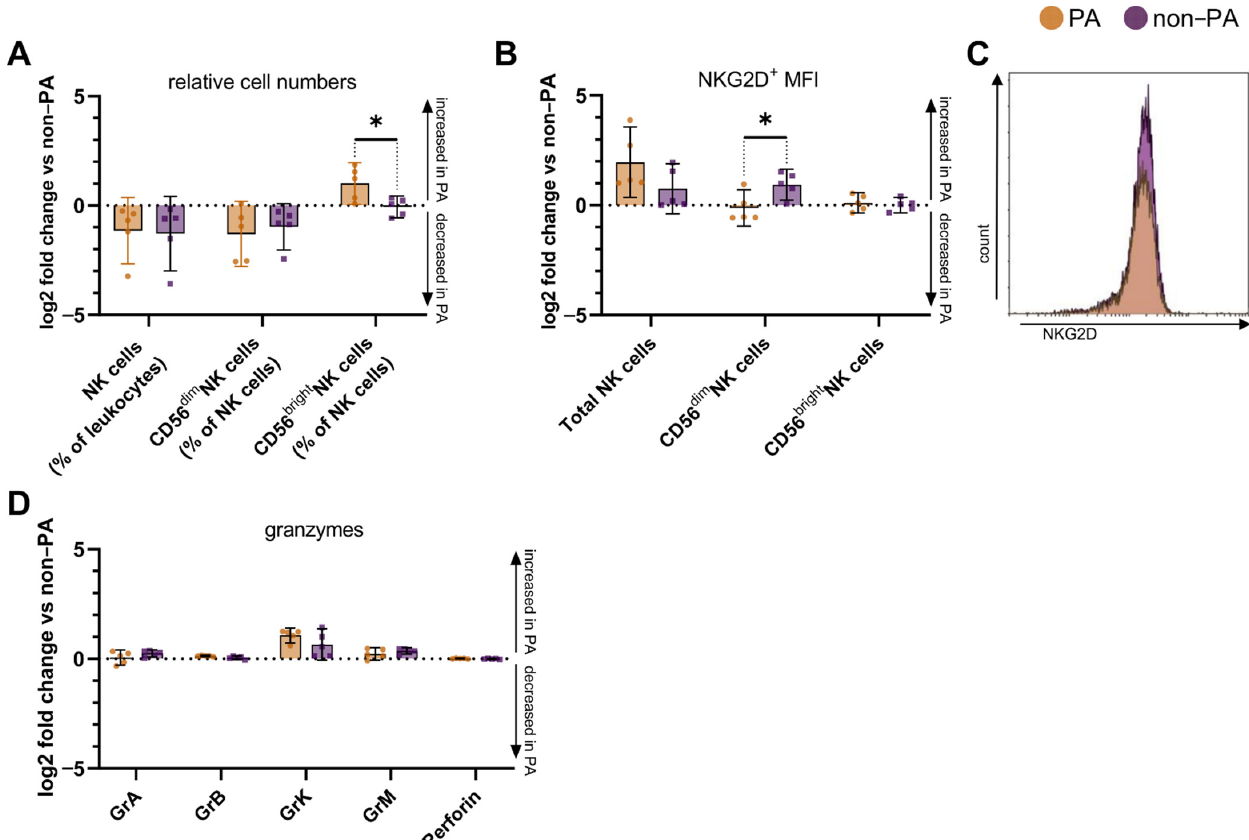
Figure 3. NK cell pattern of ASyS and DM patients with pulmonary manifestation. ( A ) Relative cell numbers from PA patients compared to non-PA. ( B ) MFI of NKG2D + on total NK cells and NK cell subsets from PA patients compared to non-PA. ( C ) Representative plot displaying histograms for NKG2D on CD56 dim NK cells. ( D ) Relative cell numbers from PA patients expressing corresponding granzyme or perforin compared to non-PA. Differences were determined by Mann– Whitney test for DM (orange) and ASyS (purple). Error bars display mean (IQR). To account for multiple comparisons, statistical significance was corrected using the false discovery rate (FDR). A threshold of Q = 5% was used for FDR. Abbreviations: ASyS = anti-synthetase syndrome, DM = dermatomyositis, Gr = granzyme, MFI = mean fluorescence intensity, NK = natural killer, PA = pulmonary affection * p < 0.05.